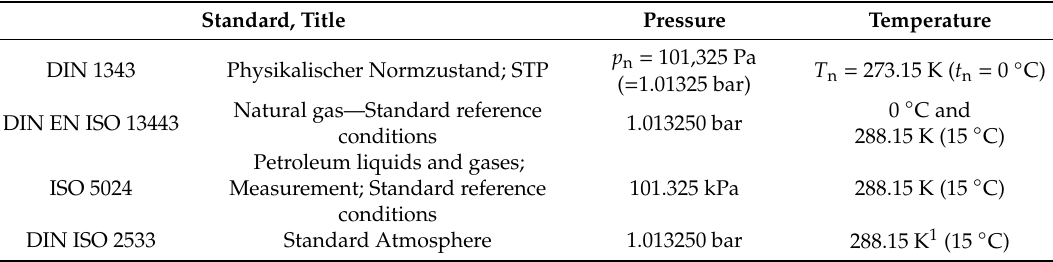
Table 3. Existing definitions of standard